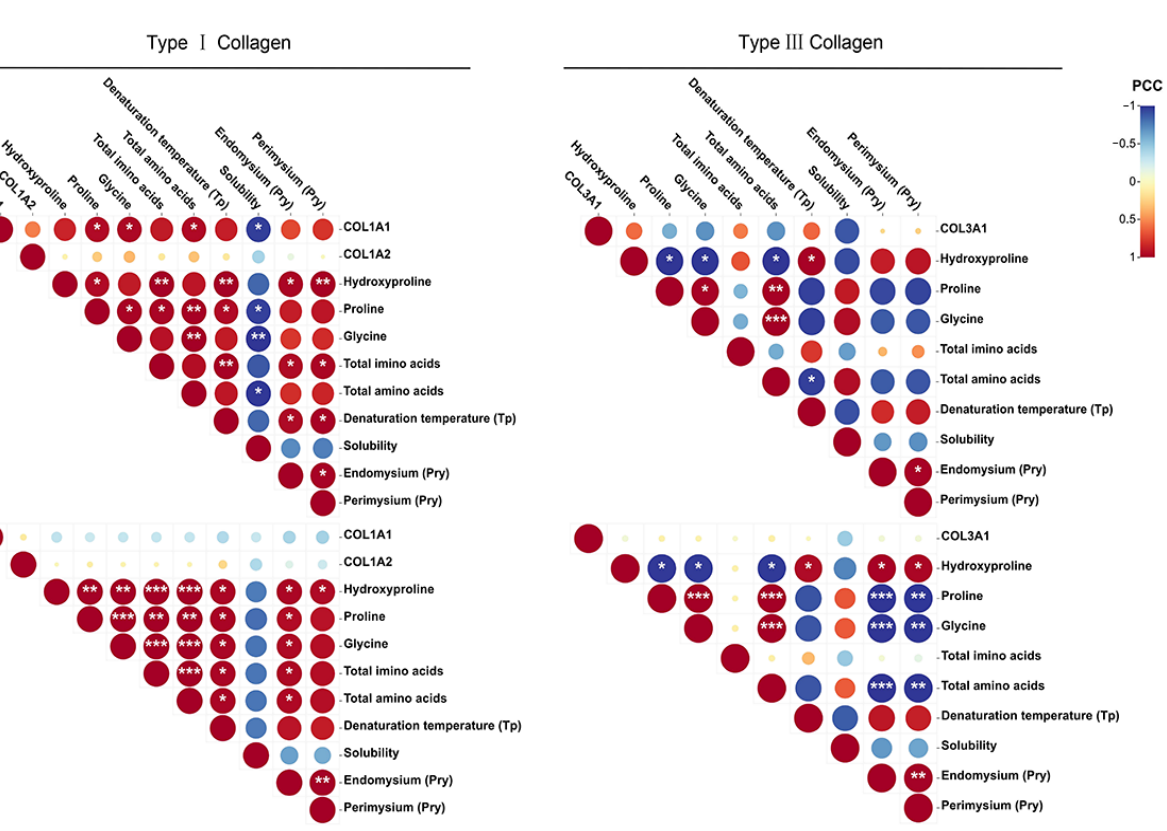
Figure 6. Correlation analysis of the collagen characteristics. The size and color of the circles indicate the strength of the correlations. PCC: Pearson correlation coefficient. * p < 0.05, ** p < 0.01, *** p < 0.001.